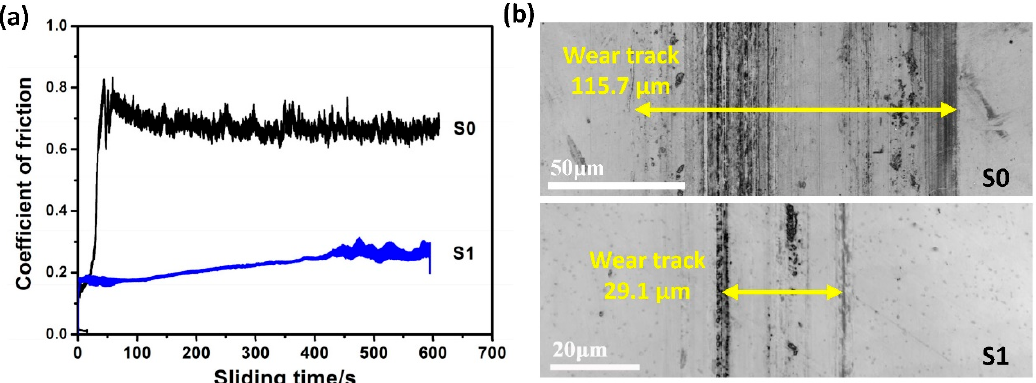
Figure 8. ( a ) Friction coefficients of various samples as a function of time and ( b ) the corresponding morphologies of the wear tracks. The applied load was 2 N.